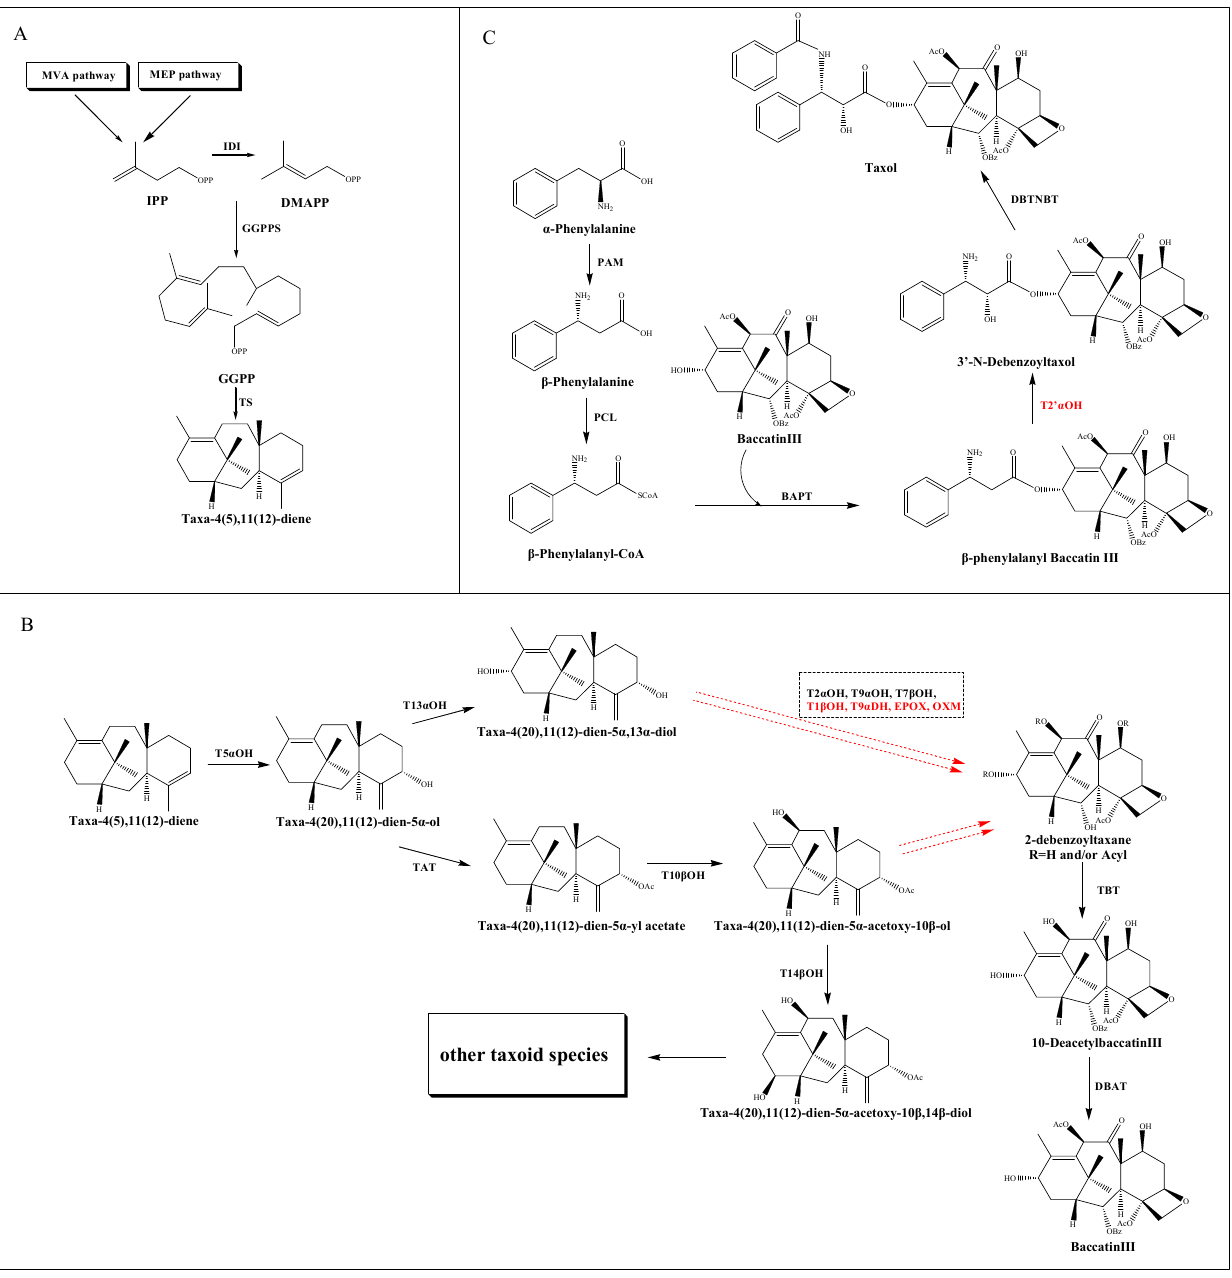
Figure 1. Putative taxol biosynthetic pathway. ( A ) The source and formation of the taxane core. ( B ) The modification of the core taxane skeleton. ( C ) The synthesis of the β -phenylalanyl-CoA side chain and the assembly of taxol. The solid arrows show the identified steps. The dotted arrows show the unknown steps. Steps marked by red color represent the uncharacterized enzymatic reactions. Dotted frame represents intermediate steps of the pathway where several enzymes and the order of their reactions are unknown.